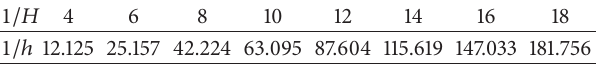
Table 1: Comparison of the scaling between 1/𝐻 and 1/ℎ .